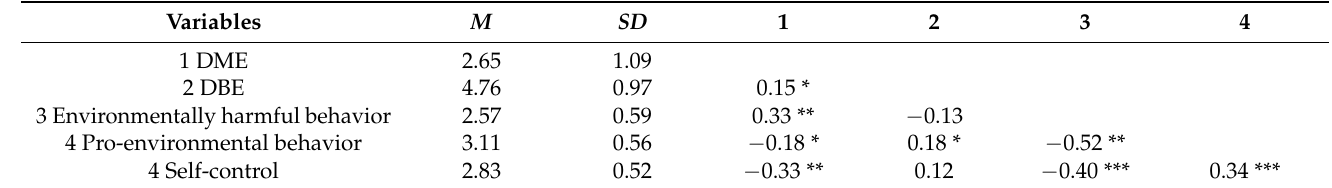
Table 1. Descriptive data and correlations of the